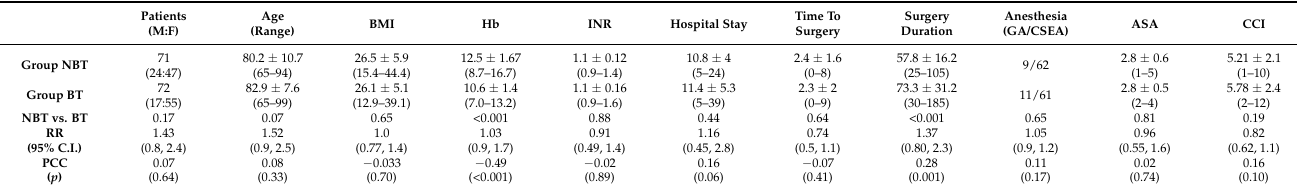
Table 1. Patient-demographic information and study results.